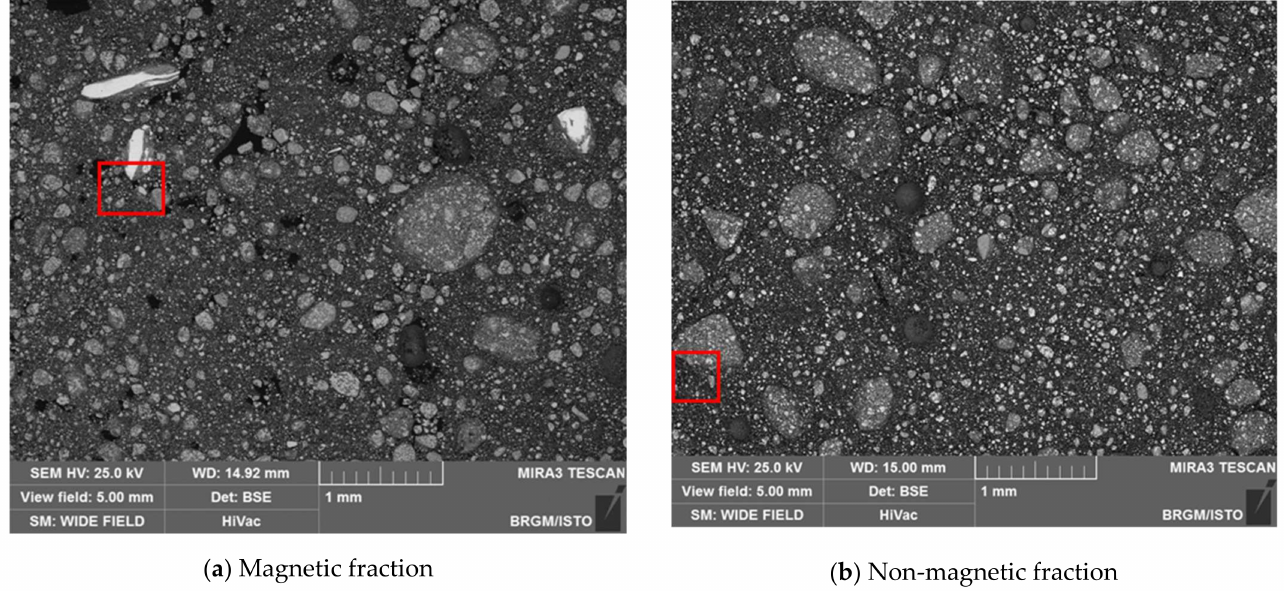
Figure 5. Textural aspect of the magnetic ( a ) and non-magnetic ( b ) fractions of the +0.25–1 mm-sized fraction and locations of the elemental mapping (red